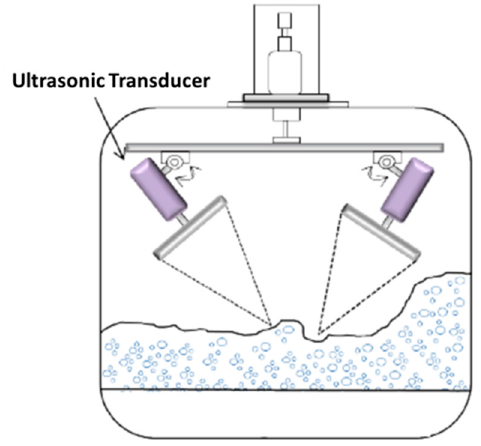
Figure 4. Schematic view of ultrasonic defoaming (reprinted with permission from Ref. [94] Copy- right 2017 Elsevier). 2017